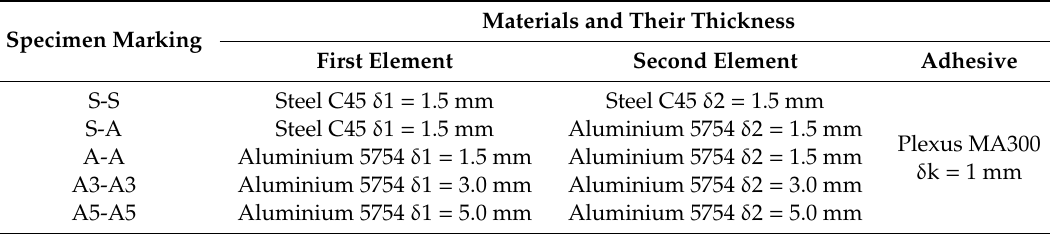
Figure 6. Dimensions of the single-lap specimens in accordance with PN-EN 1465-2009. Table 2. Types of tested joints.